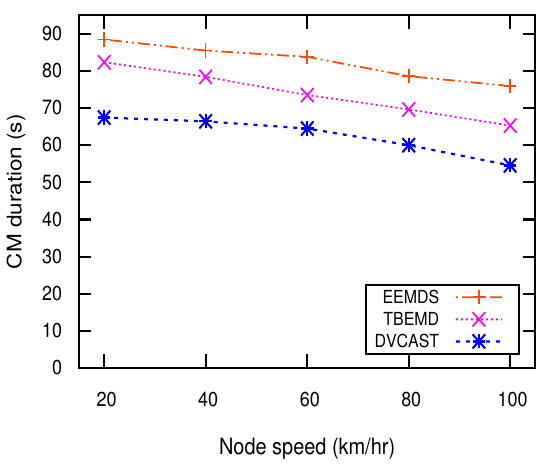
Figure 8. CM duration vs. node